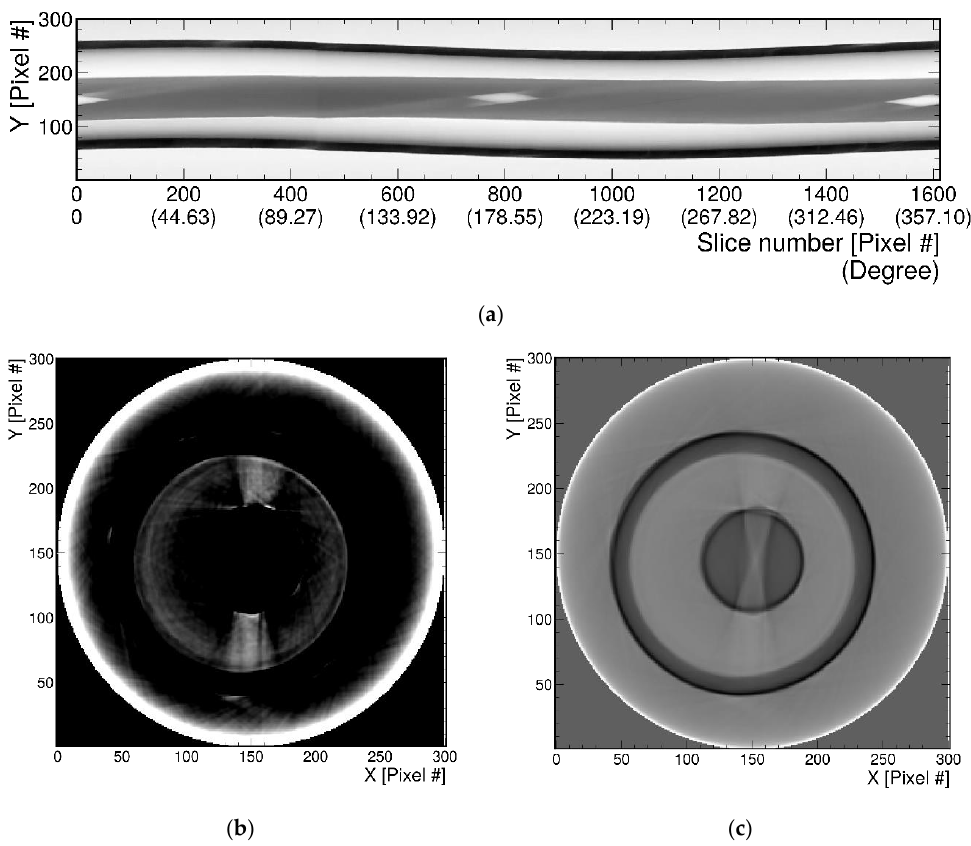
Figure 9. ( a ) 2D-pixel sinogram arrangement using the red baseline of the image inserted in Figure 6. ( b , c ) Reconstruction of the tomographic top-view images. White color in optical tomography rep- resents the dark part in CT image, while black color represents the white part. ( b ) A narrow scale contrast was applied. The large outer circle shown here is the boundary of the glass bottle, while the small inner circle is the cross-sectional boundary of the T-bar. The two rectangles located in the coordinates (150, 100) and (150, 200) are cylinder-shaped holes across the center of the cross-section of the T-bar. Due to the narrow contrast range, rectangular region from (150, 110) to (150, 190) is the part that connects the upper rectangle and the lower rectangle, and it was not visible. ( c ) A wide-scale contrast was applied. The upper and lower rectangular connection, which was not seen in ( b ), can be seen. Unlike CT images, which used X-rays, the pin-wheel-shaped image at the center was generated by the optical effect of visible light. At the same time, a small circle appeared in the center of the rod, and it was created by ill-posed conditions, in which many solutions exist in inverse